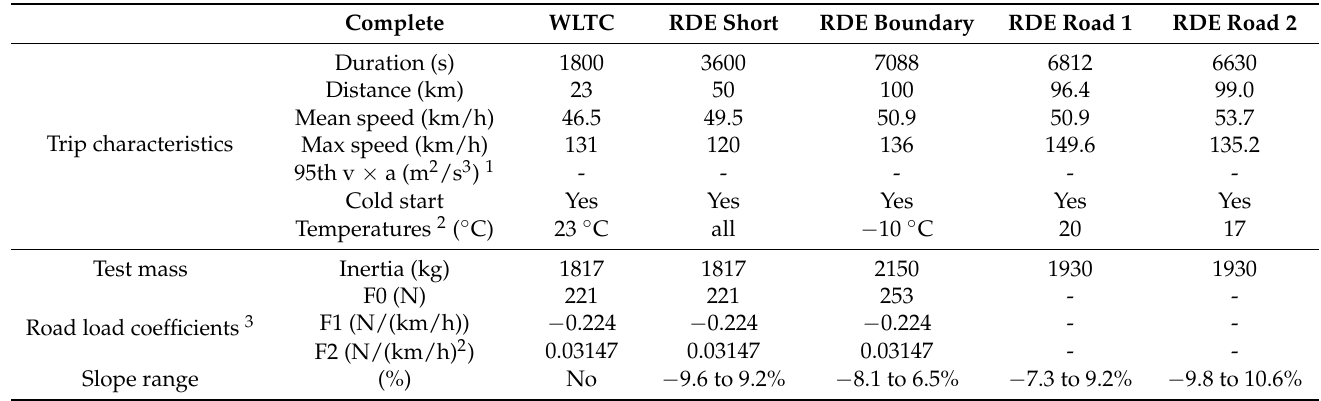
Table A1. Characteristics of the complete cycles.